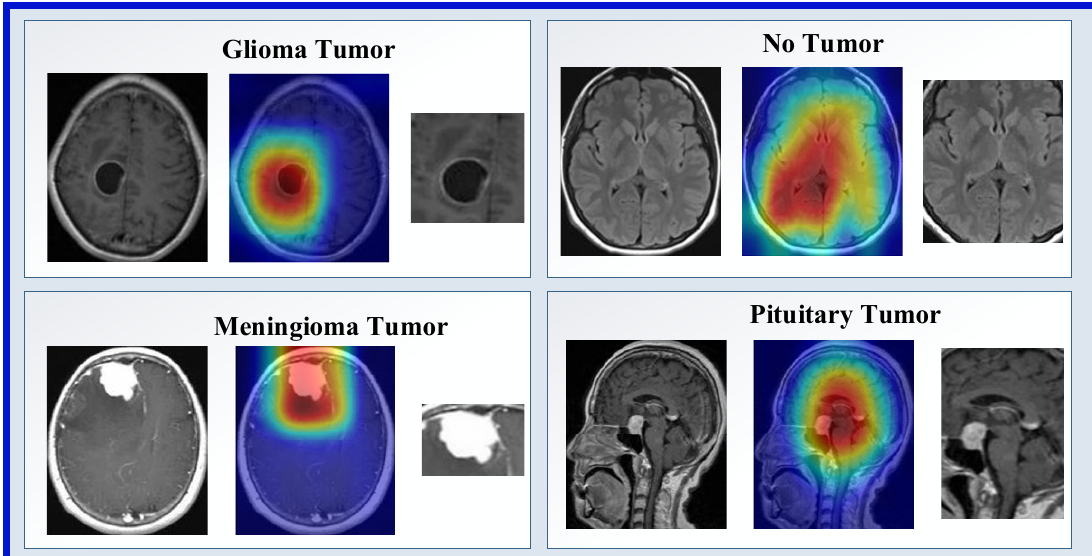
Figure 5. Examples of ROI and hot map images.